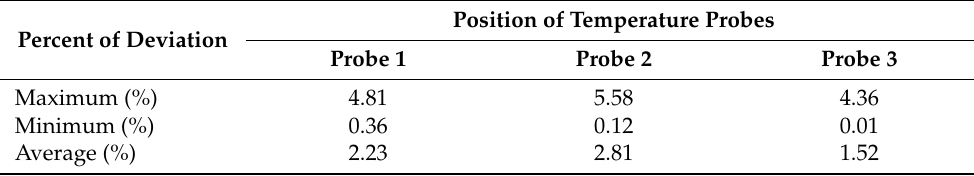
Figure 7. The validation results between the experimental and simulation models. Table 4. The deviation between the experimental and simulation